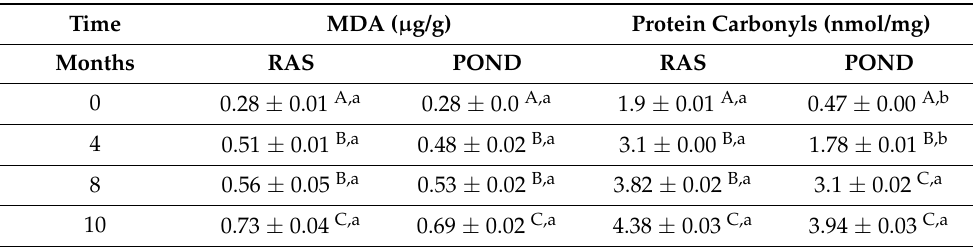
Table 5. MDA ( µ g/g) and carbonyl content (nmol/mg) parameters in perch fillets from RAS and pond rearing systems during frozen storage at − 20 ◦ C (mean ± S.D., n = 6). Time MDA ( µ g/g) Protein Carbonyls (nmol/mg) Months RAS POND RAS POND